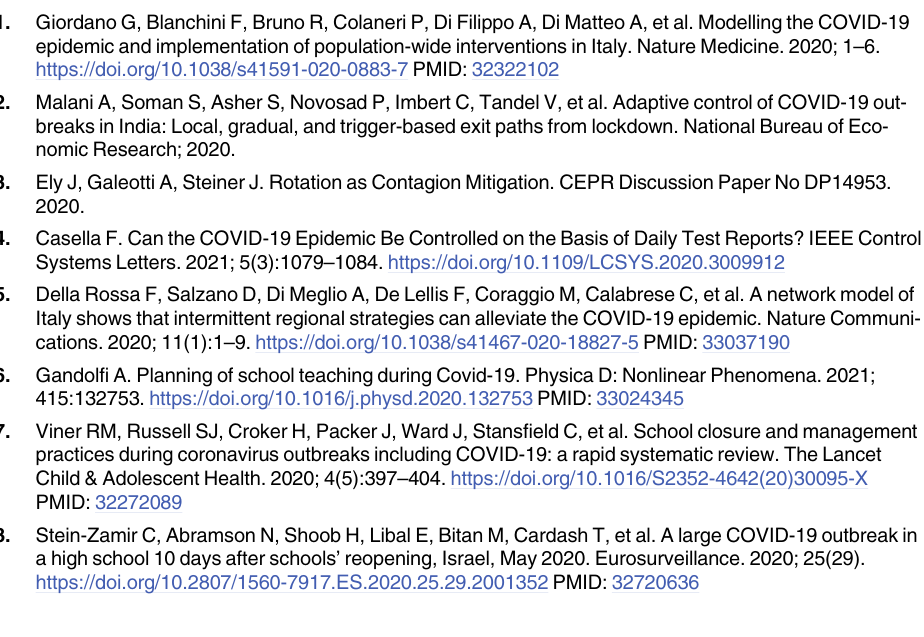
S22 Fig. Four simulation runs of epidemic propagation inside the random uniform graph (similarly to Fig 5). Among the runs producing an outbreak under no strategy, we selected the first four that produce a median number of infections, that is